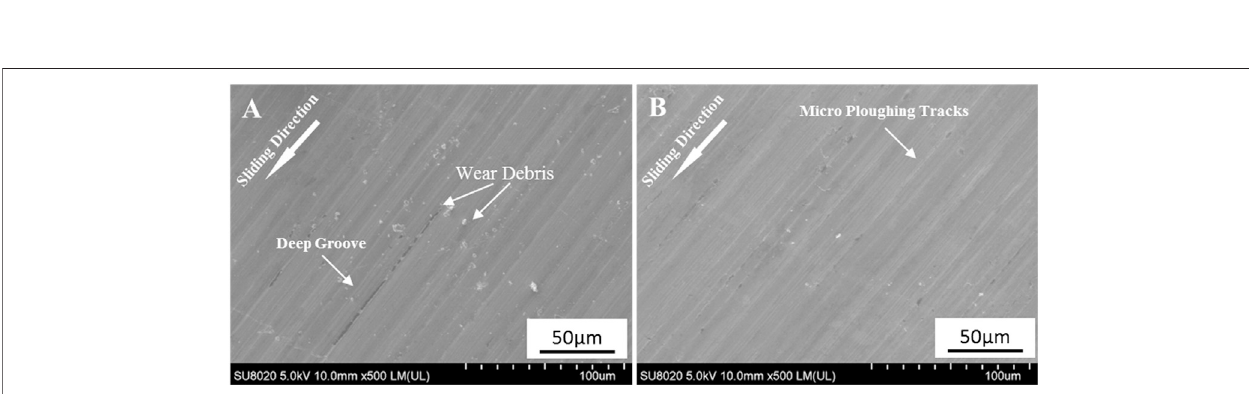
FIGURE 10 | SEM images of the worn surface of sintered samples from different powder mixtures. (A) EL powder mixtures; (B) PD powder mixtures.